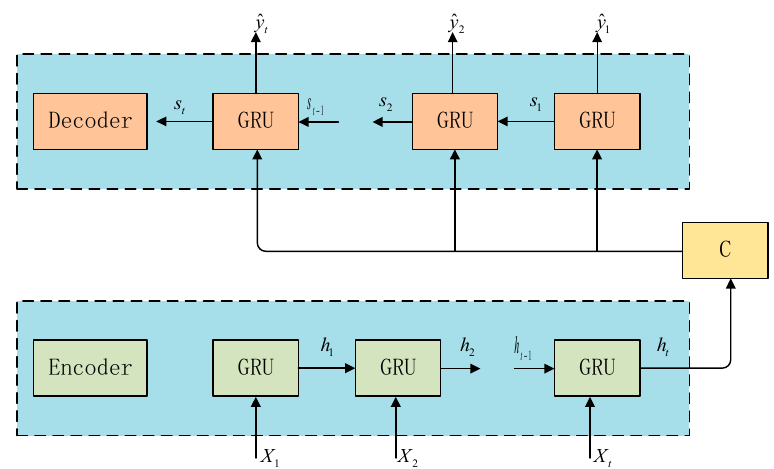
Figure 1. Traditional encoder-decoder prediction structure.